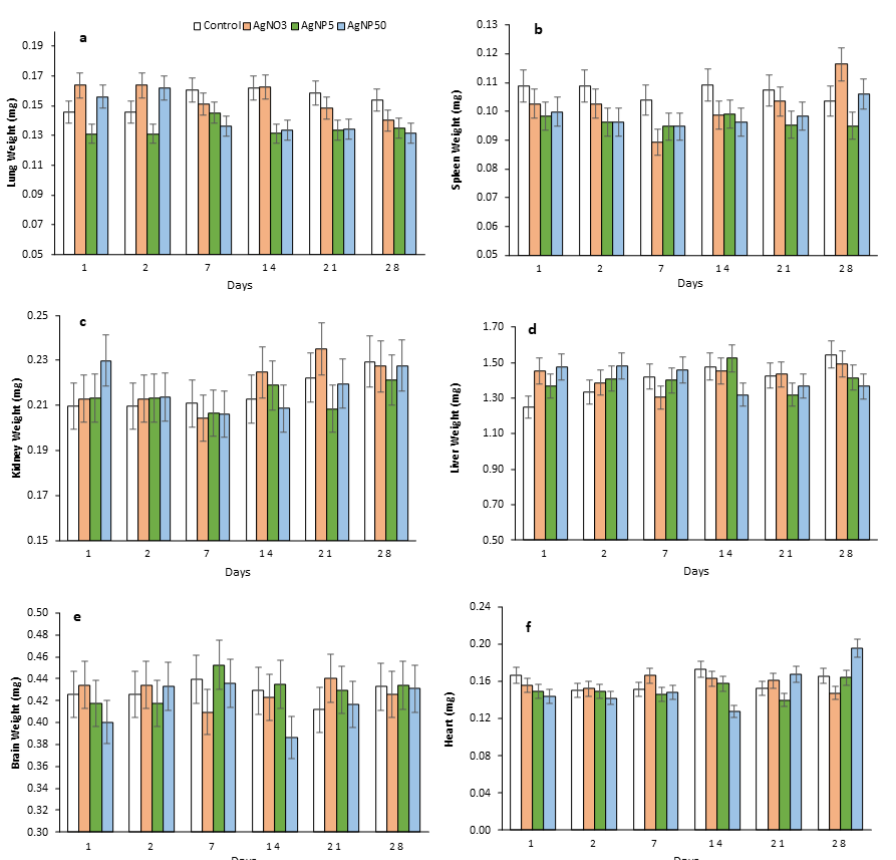
Figure 3. Mice relative organ weights over a 28-day recovery time after repeated intratracheal instillations of saline (control), AgNO 3 , AgNP5 and AgNP50. ( a ) WBC; ( b ) lymphocytes; ( c ) neutrophils; ( d ) monocytes; ( e ) eosinophils; ( f ) basophils.